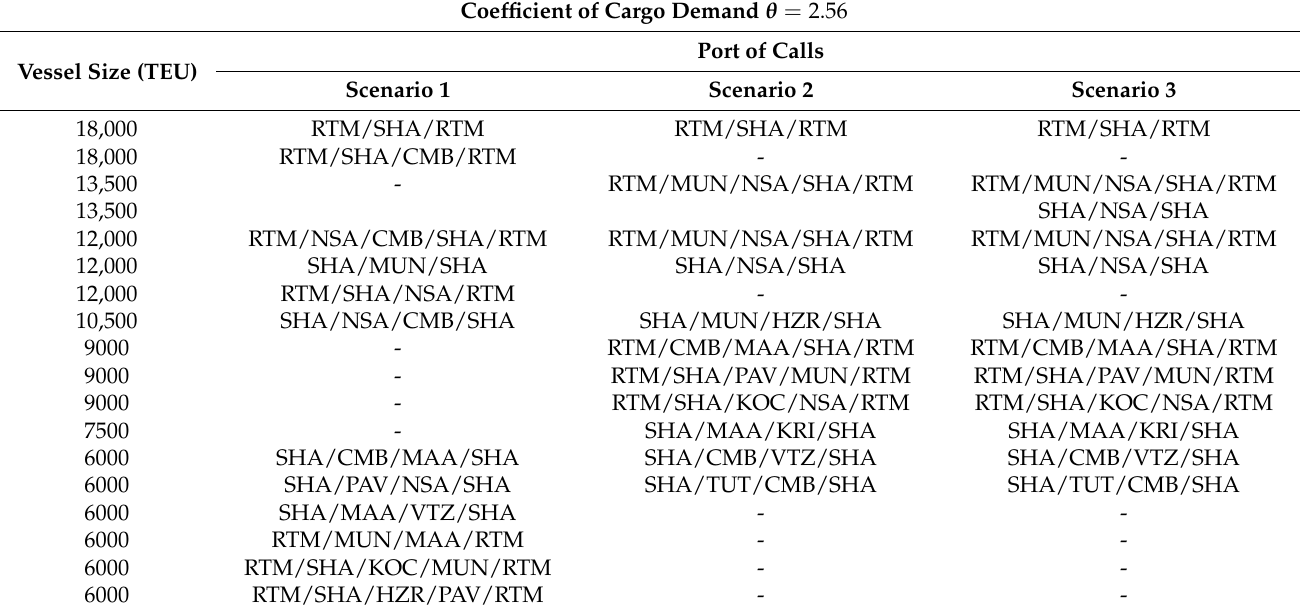
Table 7. Results of optimized services at θ = 2.56. Coefficient of Cargo Demand θ =